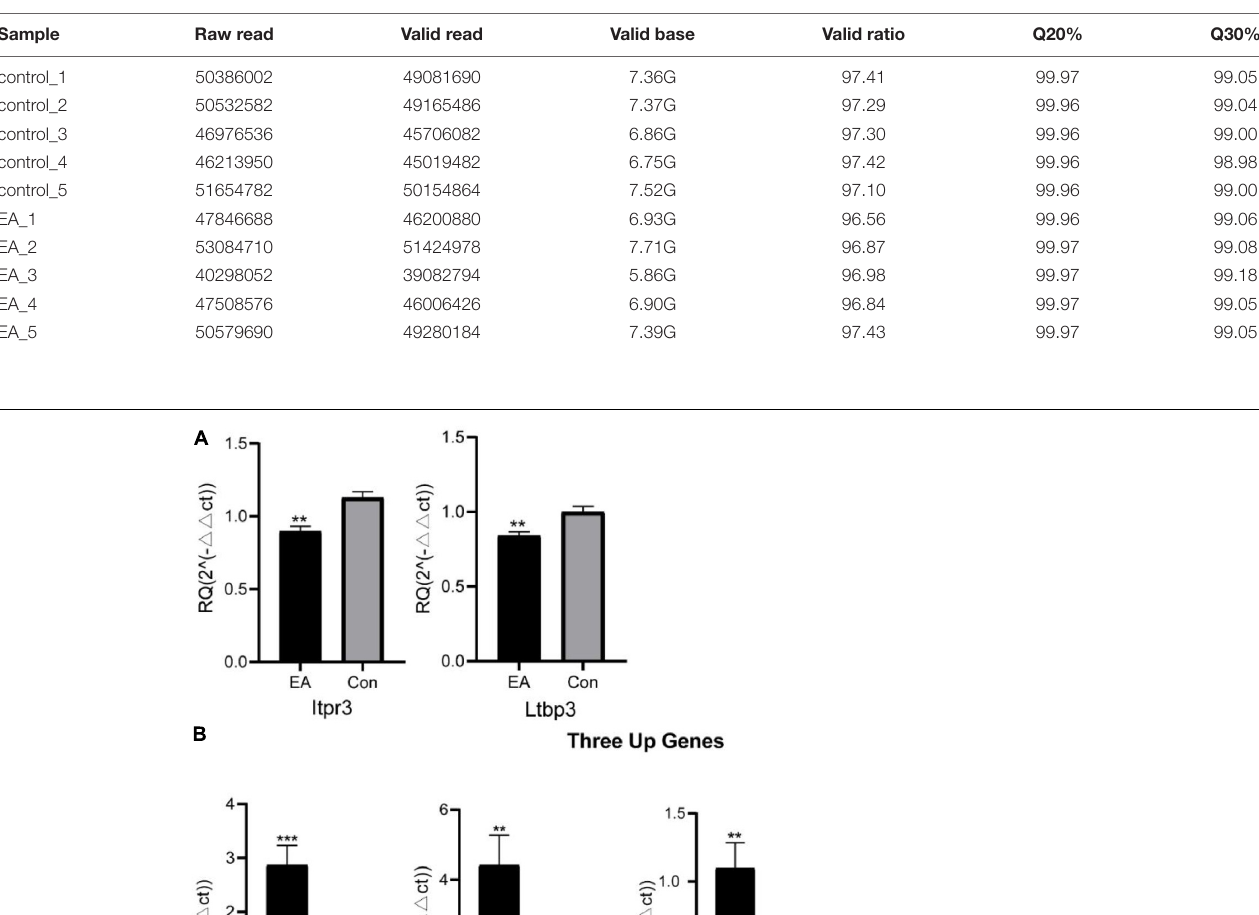
Frontiers in Neuroscience |